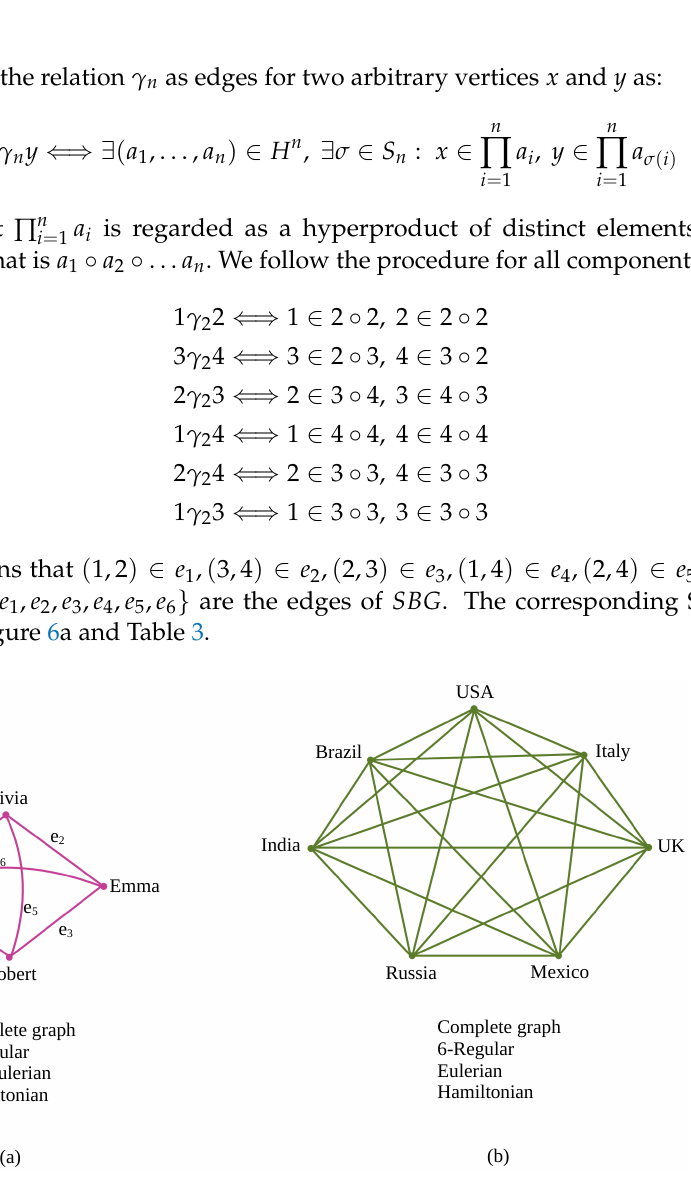
Figure 6. SBGs of G corresponding to ( a ) Application 1 and ( b ) Application 2. Table 3. SBGs of G